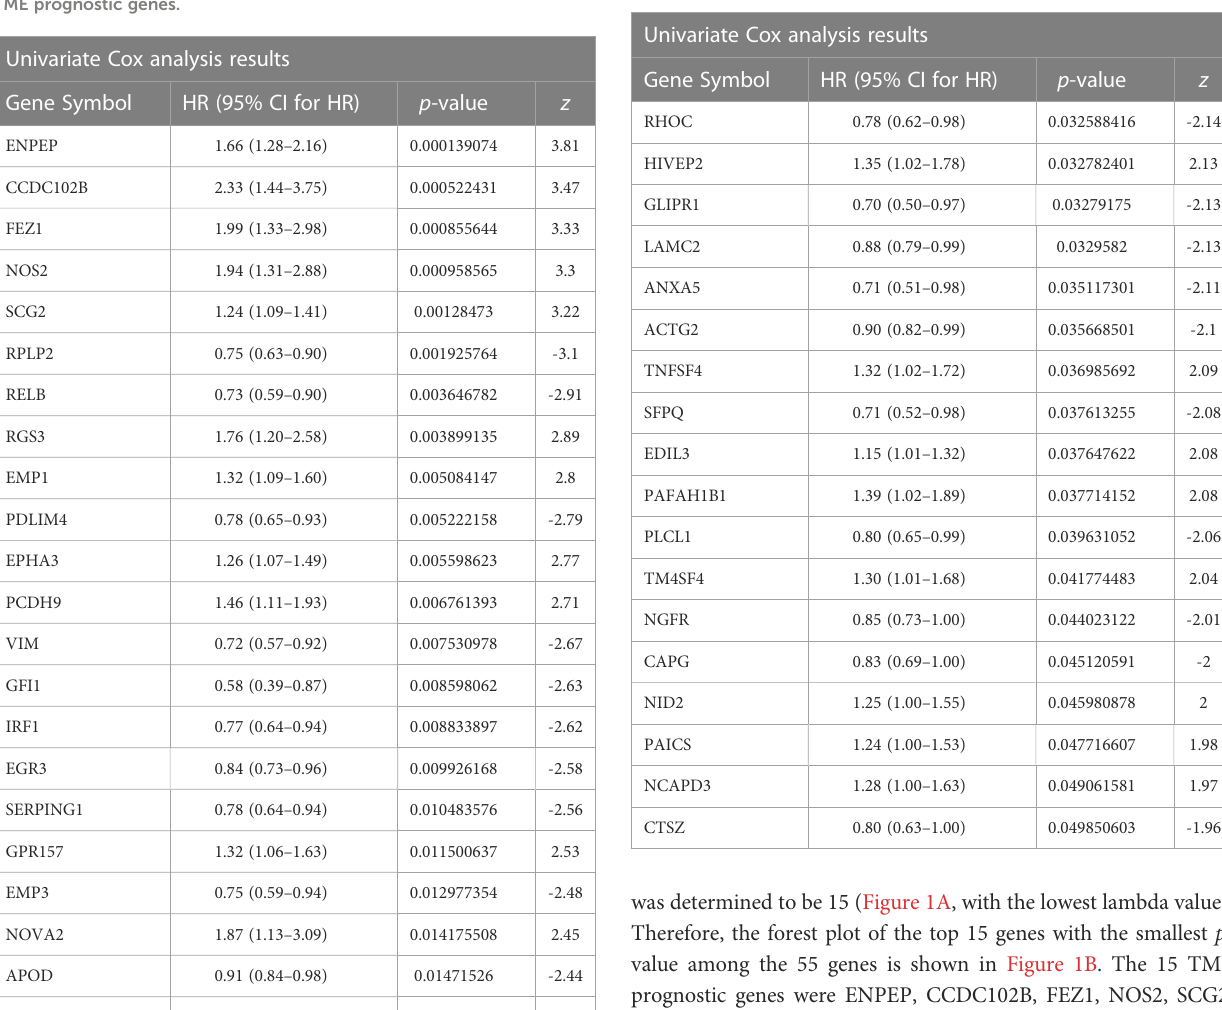
TABLE 1 The Univariate Cox analysis results for differentially expressed TME prognostic